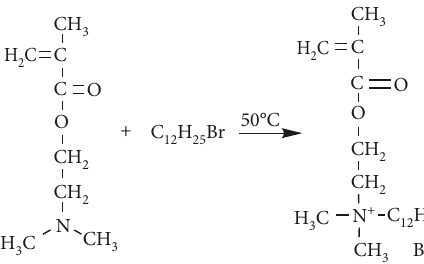
Figure 1: Schematic of synthesis of